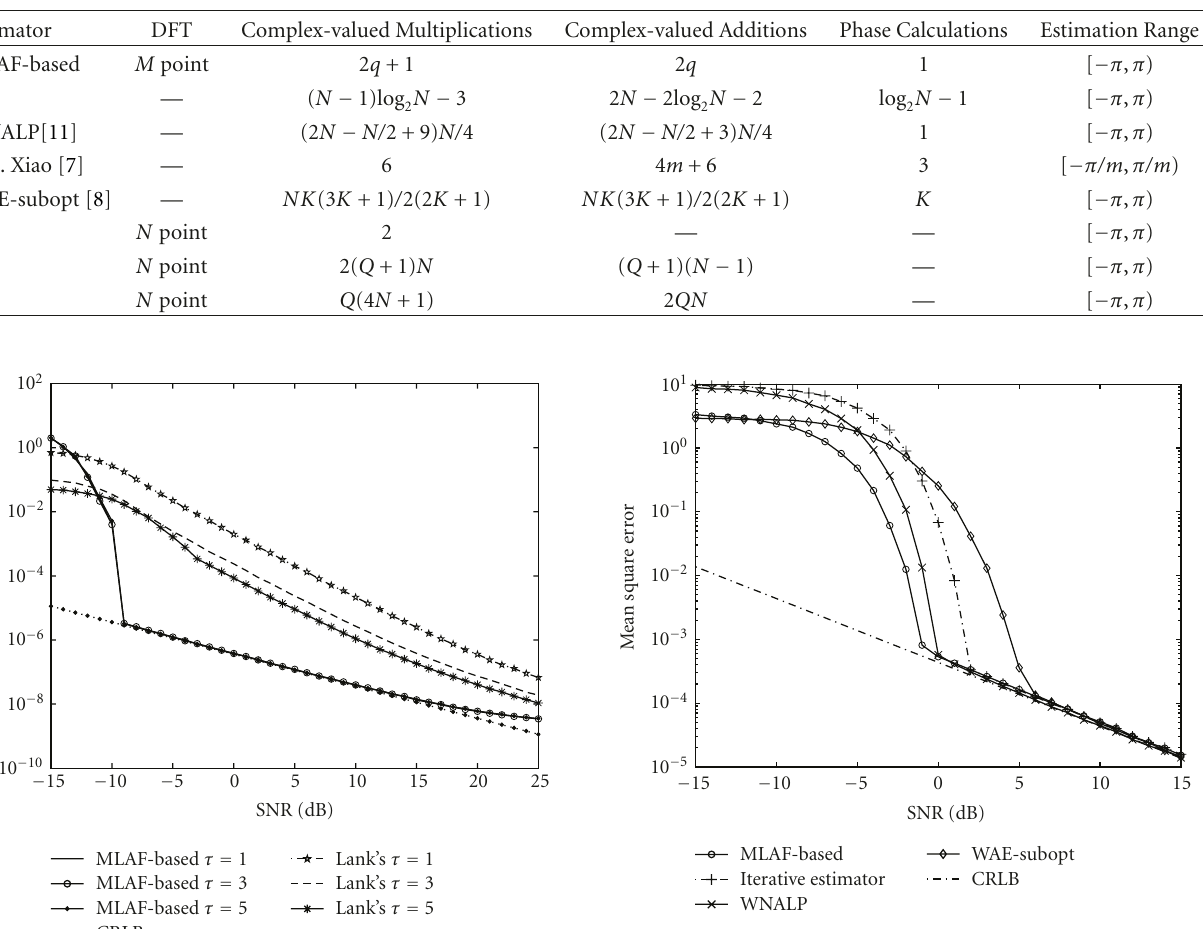
Table 1: Number of complex-valued multiplications/additions and phase calculations for estimators.